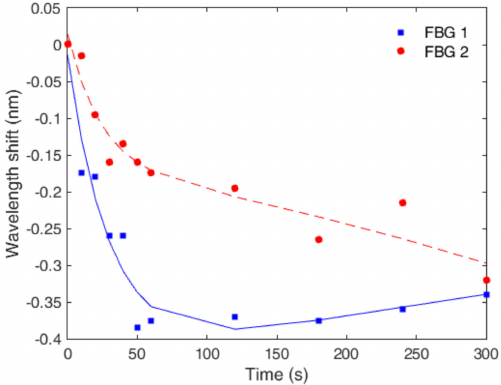
Figure 8. Creep response and exponential regression for FBGs 1 and 2 for 5 min.